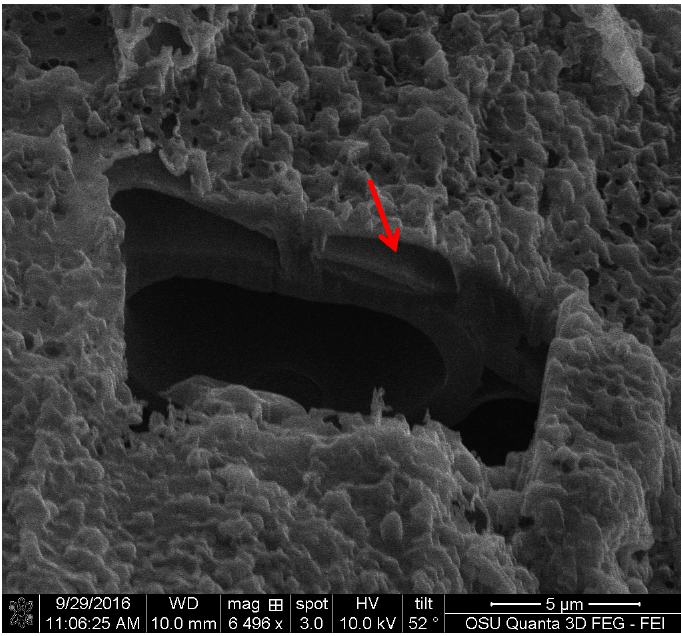
Figure 12. FIB cross-section of the extracted pigment of C. aeruginosa with cottonwood, showing large void spaces between the wood cell wall and the pigment, pointed to with an arrow. FEI QUANTA 3D dual beam SEM/FIB.